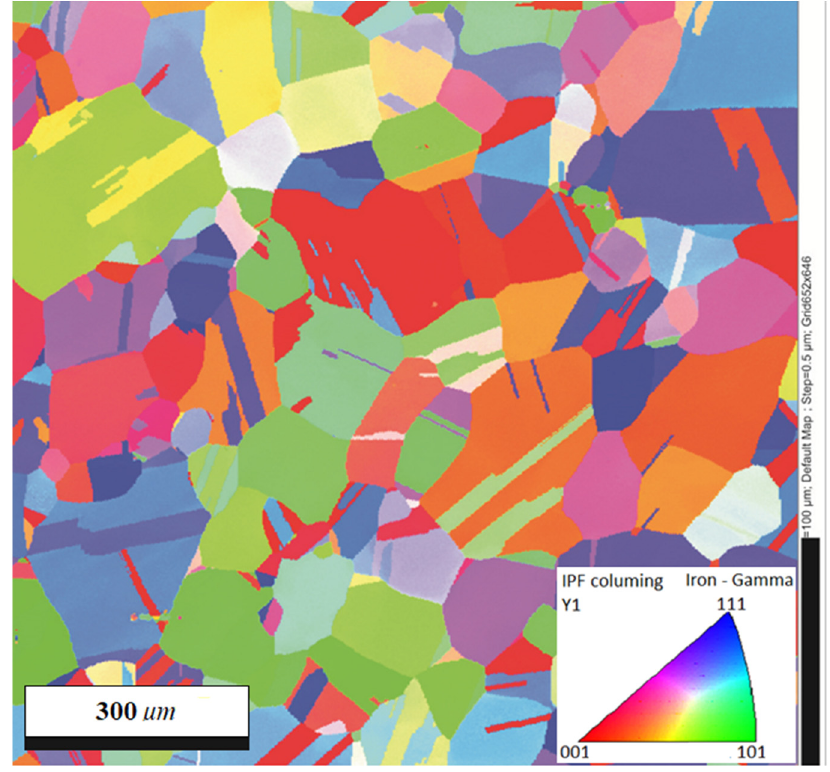
Figure 3. Distribution of grain orientation in the tested specimens (EBSD).